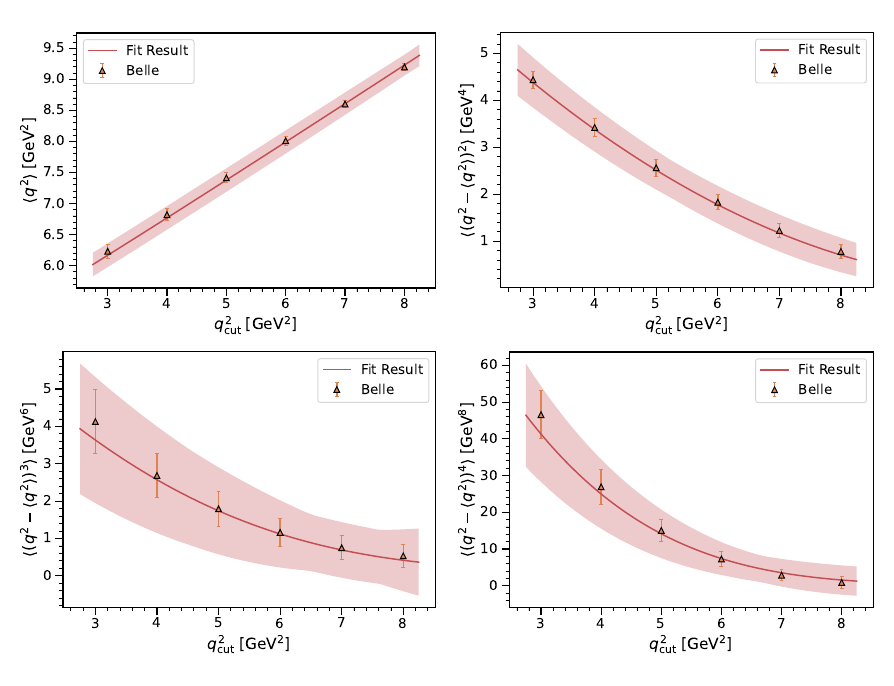
Table 7 . Results of our default fit using only Belle data for | V cb | , m kin HQE parameters, and the correlation parameters ρ GeV at the appropriate power.